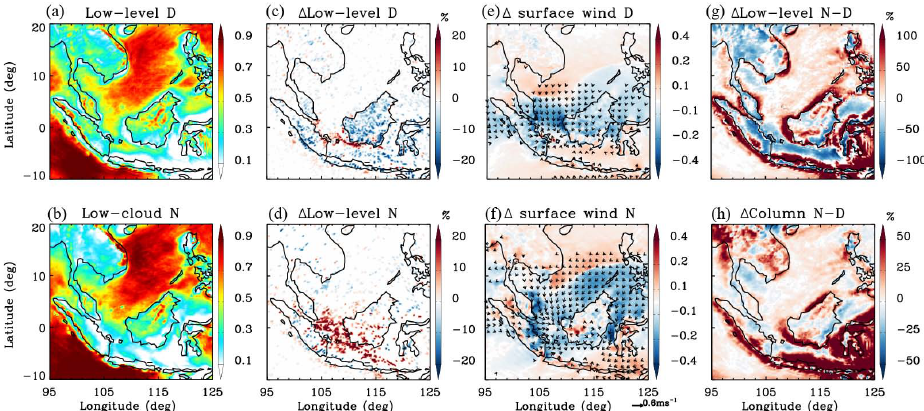
Fig. 7. Distribution of monthly averaged variables in October 2006. (a) , (c) and (e) in top row are simulated for daytime (a) low-level cloud fraction, (c) the differences of low-level cloud fraction, and (e) the differences of surface wind speed. (b) , (d) and (f) are same as (a) , (c) and (e) but for nighttime. (g) is the difference between (d) and (c) ; (h) is the difference of column cloud between nighttime and daytime. All the difference showed here with 95% confidence by paired samples t test. Clouds below 2000m are considered low-level clouds. Note in panel (e) and (f) the color-filled contours represent the wind speed. The OC/BC ratio is 10 in the simulation.